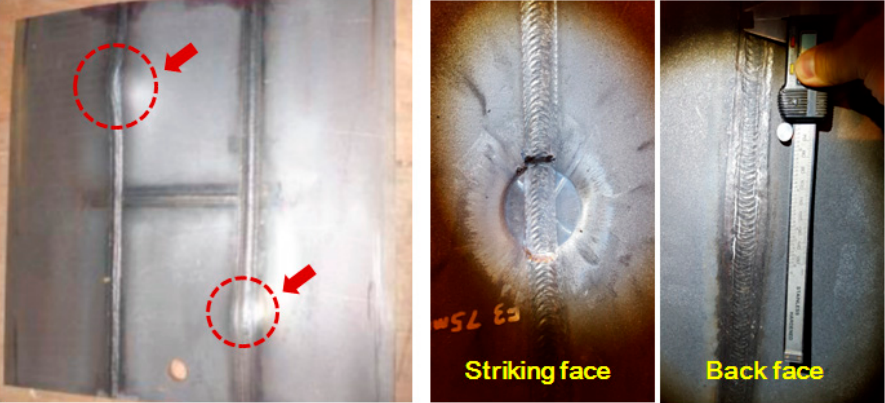
Figure 12. Striking and back face of the H-plate specimens after the ballistic test.